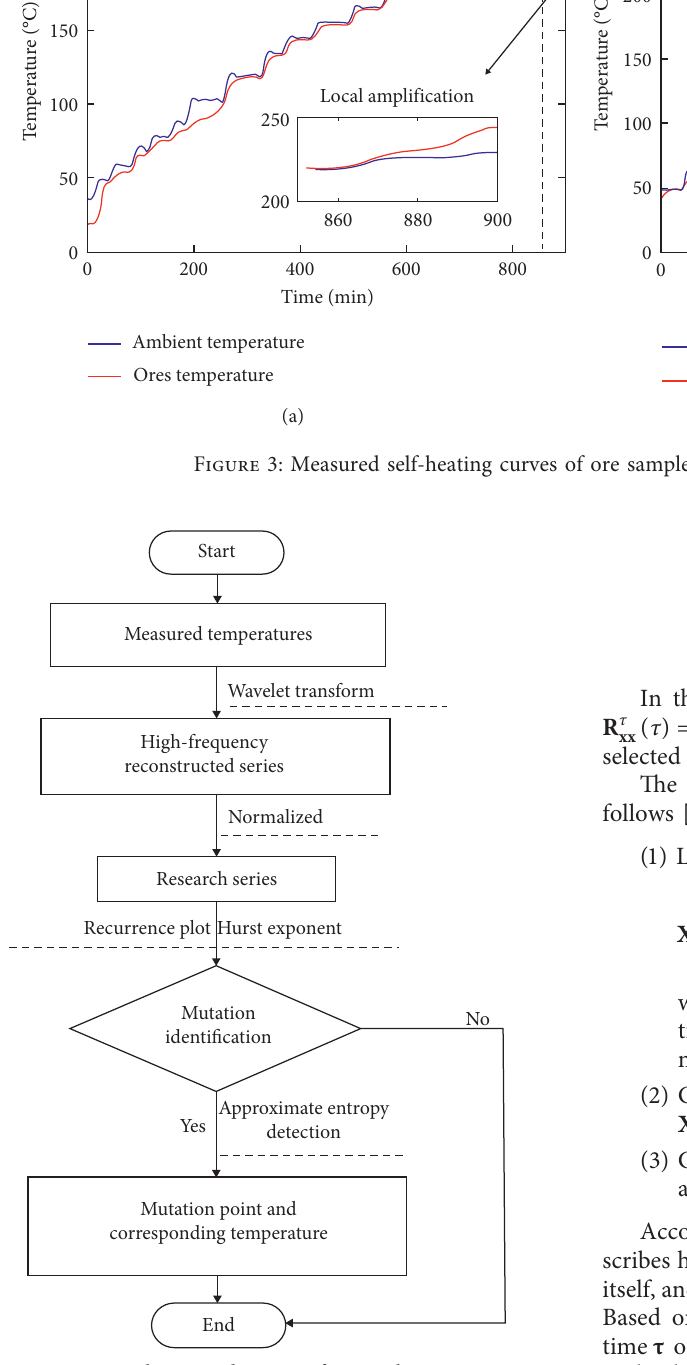
Figure 4: Schematic diagram of research